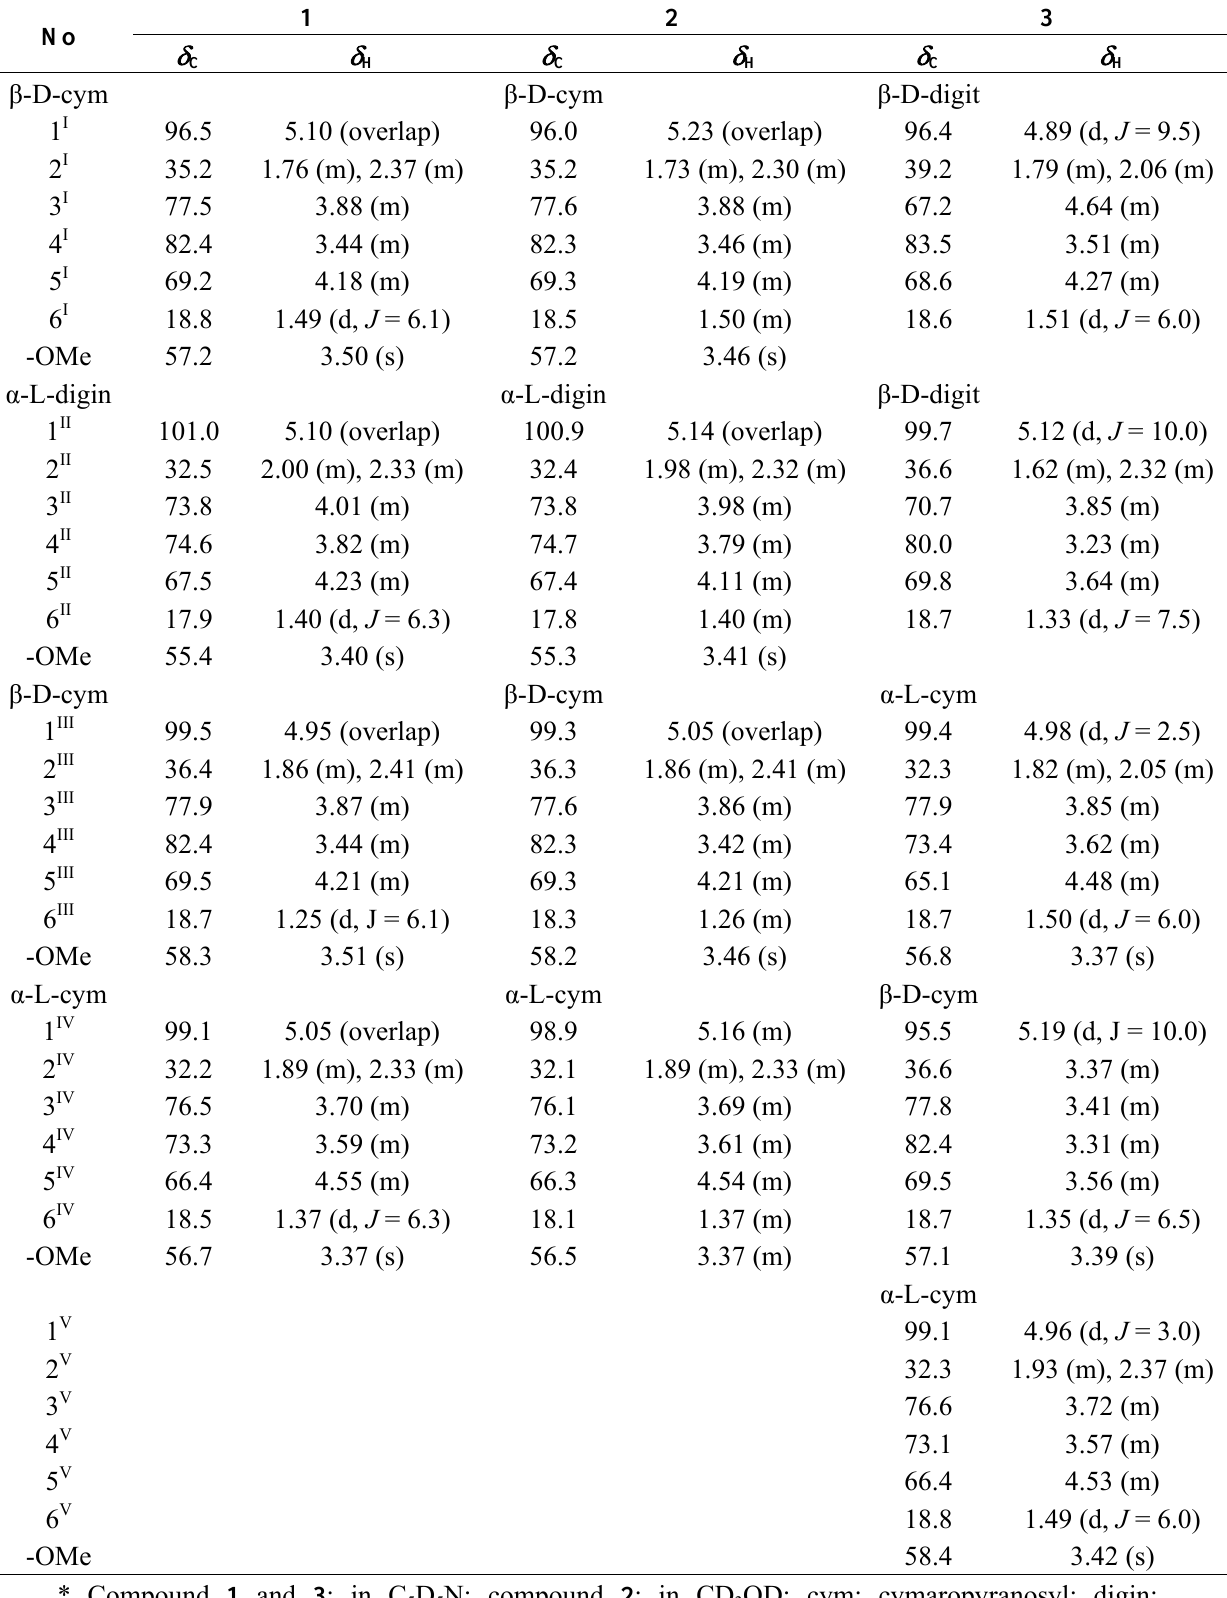
Table 2. NMR data of the sugar moieties of compounds 1-3 δ in ppm, J in Hz.